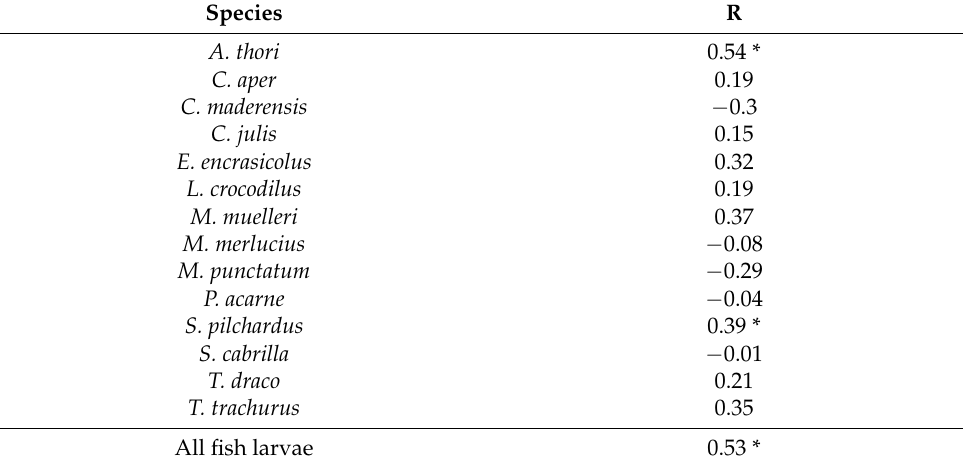
Table 4. Pearson’s correlation coefficients between the vertical distributions (weighted mean depth, WMDs) of fish larvae and mesozooplankton, where the * stands for p <